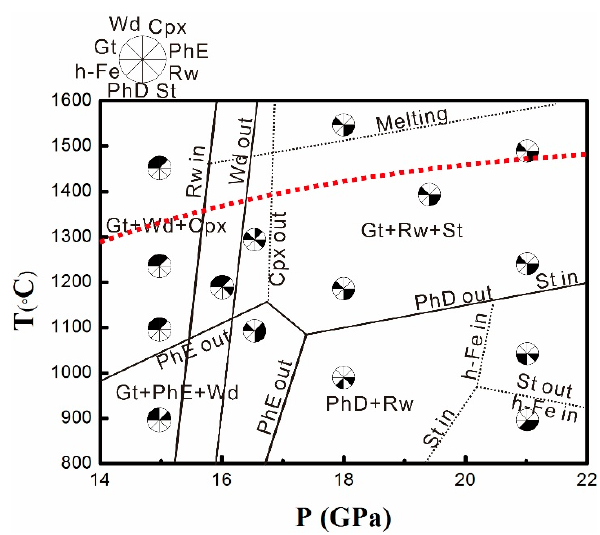
Figure 1. Phase relations in the system MgO-Al 2 O 3 -FeO-SiO 2 with 2% H 2 O. Solidus lines are obtained according to the quenched samples combined with reported phase relation in CaO-MgO-Al 2 O 3 -SiO 2 - pyrolite with 2% H 2 O [24]. Dashed black lines are the proposed phase boundaries based on phase assemblages in recovered samples due to the limited data point at these regions. The dashed red line is proposed areotherm [17,25]. Gt, garnet; Cpx, clinopyroxene; Wd, wadsleyite; Rw, ringwoodite; St, stishovite; PhE, phase E; PhD, phase D; h-Fe, iron-rich hydrous phase.